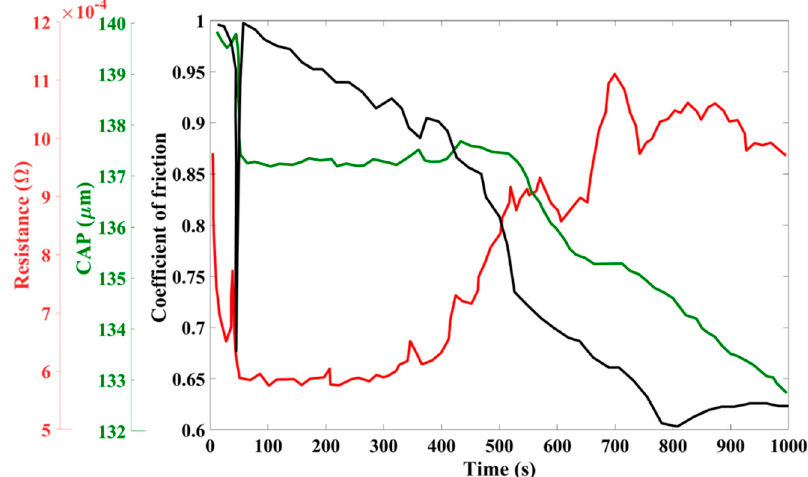
Figure 3. In-situ measurement of electrical contact resistance (ECR in Ω), wear depth (in µm), and coefficient of friction.